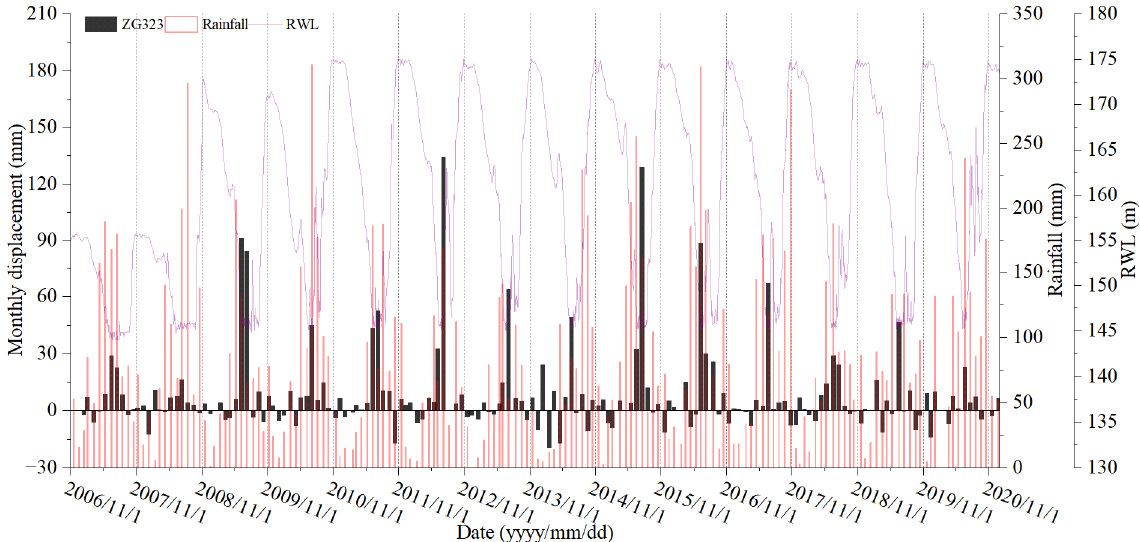
Figure 8. Monthly displacement corresponds to the reservoir water level and monthly rainfall.